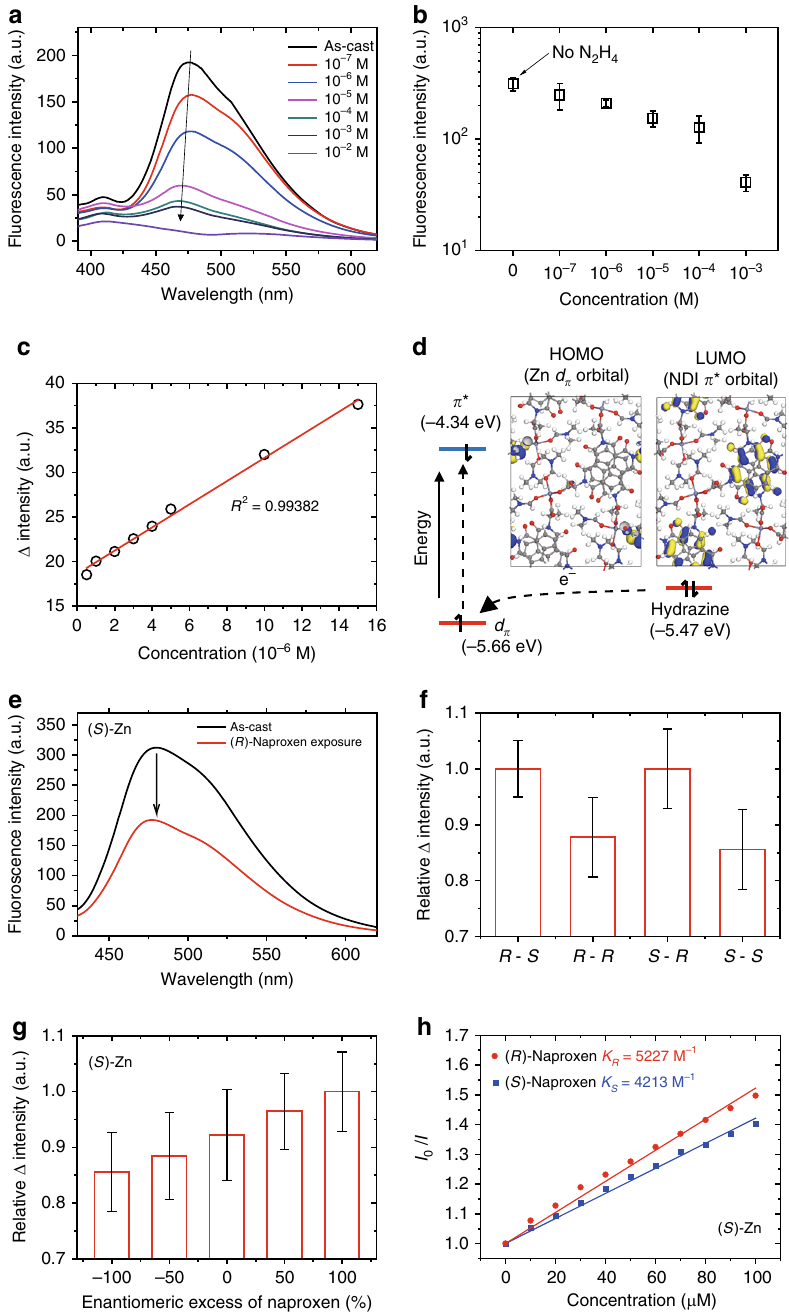
Fig. 4 Photoluminescent sensing using AlaNDI-Zn SBCPs. a Quenching of the fl uorescence intensities of ( Rac )-AlaNDI-Zn dispersed in ethanol medium (0.06 mg mL -1 ) under different concentrations of hydrazine. b Fluorescence intensities of ( Rac )-AlaNDI-Zn dispersed in ethanol medium under different concentrations of hydrazine at λ max = 475 nm (an excitation wavelength of 360 nm was chosen). c Linear fi tting of intensity change vs. the concentration of hydrazine at λ max = 475 nm. d Photoluminescent sensing mechanism based on HOMO/LUMO formalism of the heterochiral AlaNDI-Zn SBCP surface and hydrazine. The carbon, hydrogen, oxygen, nitrogen, and zinc atoms of AlaNDI-Zn SBCPs are colored gray, white, red, blue, and thin-purple, respectively. e Quenching of the fl uorescence intensity of ( S )-AlaNDI-Zn under ( R )-naproxen (10 – 3 M) in ethanol medium. f Relative fl uorescence intensities of AlaNDI- Zn dispersed in ethanol medium under different chiralities of naproxen (10 – 4 M) at λ max = 475 nm, e.g., R - S means (( R )-AlaNDI-Zn-( S )-naproxen). g Relative fl uorescence intensities of AlaNDI-Zn dispersed in ethanol medium under different enantiomeric excesses of naproxen (10 – 4 M) at λ max = 475 nm. h Linear Stern – Volmer plots for the enantiodifferentiating fl uorescence sensing of ( S )-AlaNDI-Zn dispersed in ethanol medium for ( S )-naproxen and ( R )-naproxen. The average PL intensities were taken from the 50 data points collected in different fi ve samples for all PL sensing